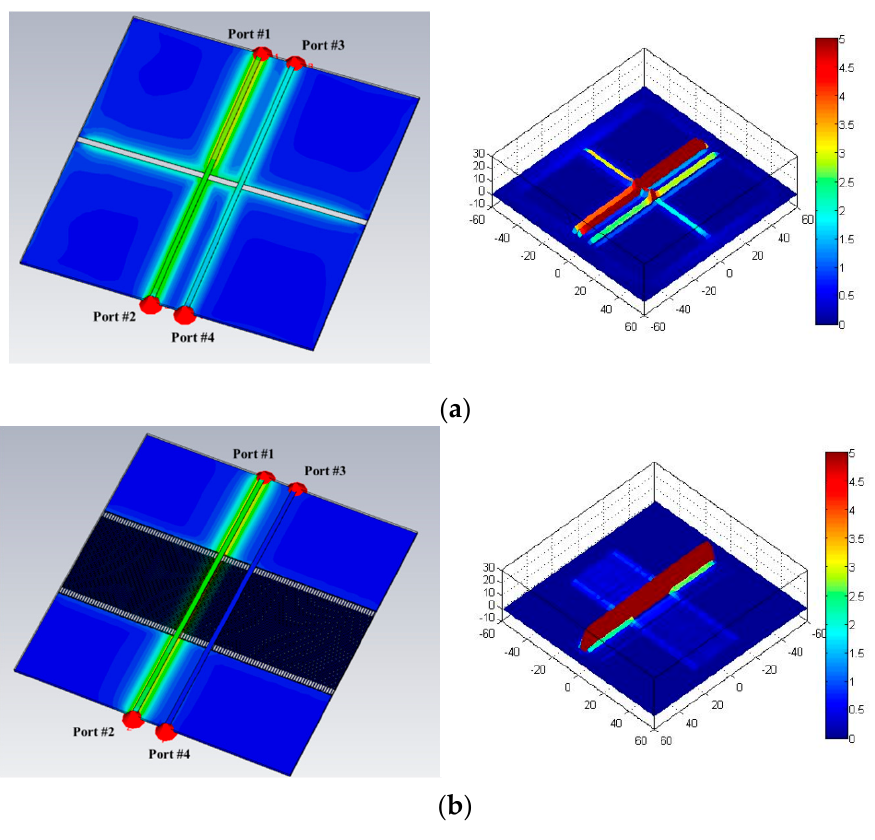
Figure 9. Current distributions on the straight and meander split power or ground plane at 2 GHz. ( a ) Straight split plane; ( b ) meander split plane.